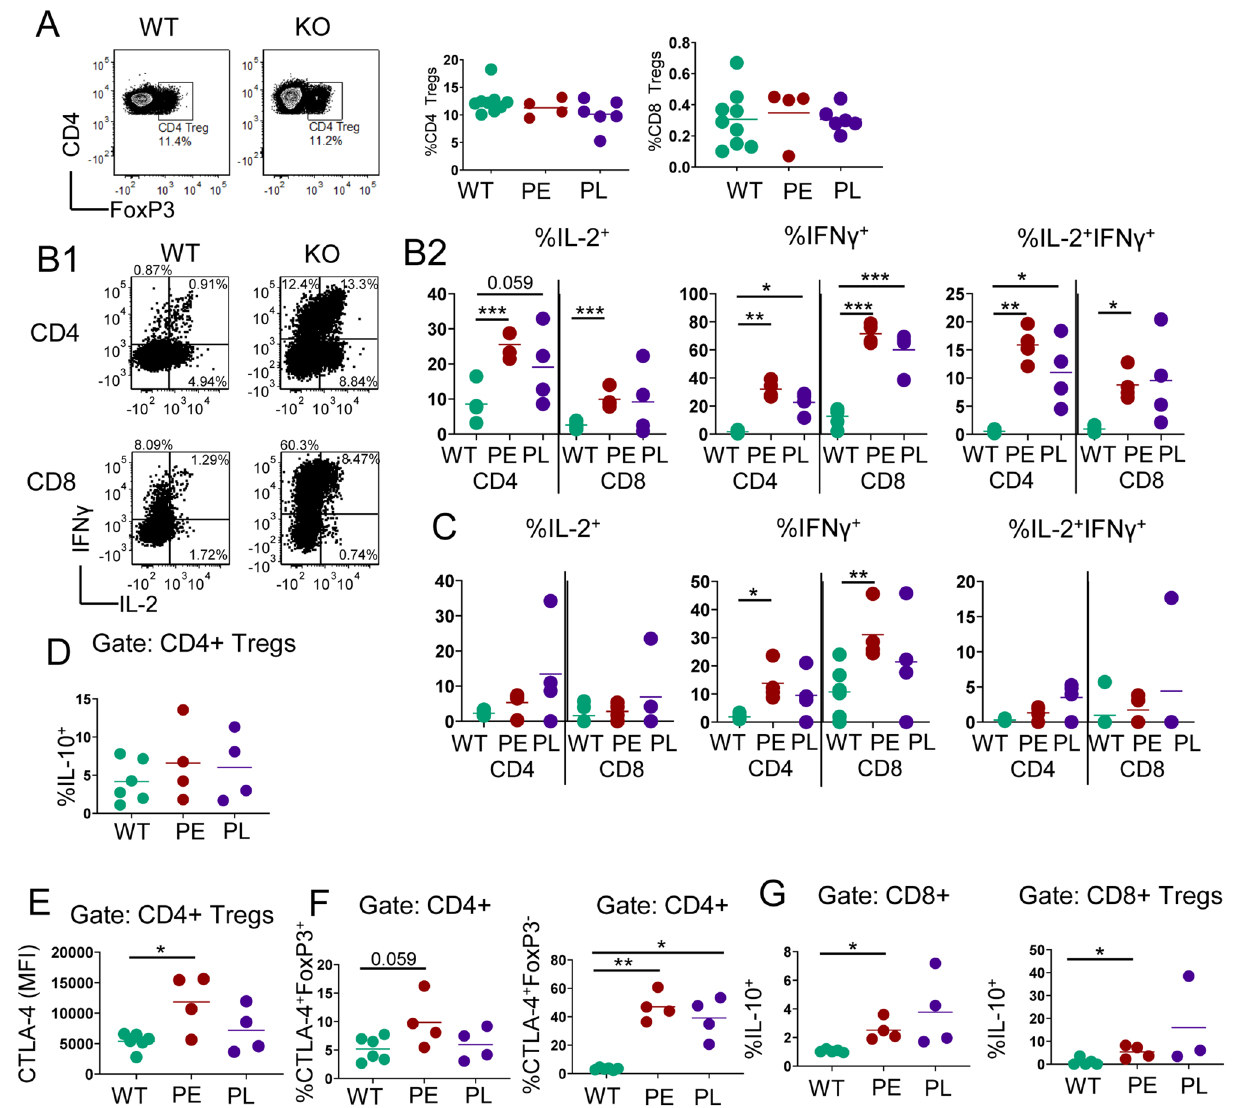
Figure 4. IL-2Rα-KO Tregs acquire effector functionality. ( A ) Representative flow plots, and frequency of CD4 and CD8 Tregs in the spleen in 19-day-old WT and IL-2Rα-KO mice. n = 4–11 mice per experimental group. Representative flow plots and frequency of T cells producing IL-2 and IFNγ in 19-day-old WT and IL-2Rα-KO LN T cells ( B1 , B2 ) or Tregs ( C ) post 5-h PMA and ionomycin stimulation. n = 4–6 mice per experimental group. ( D ) CTLA-4 expression on CD4 Treg cells at day 19 by mean fluorescent intensity (MFI). ( E ) Frequency of IL-10+ 19-day-old WT and IL-2Rα-KO CD4 Treg cells post 5-h PMA and ionomycin stimulation. ( F ) Frequency of CTLA-4+FoxP3+CD4 T cells or CTLA-4+FoxP3− CD4 T cells are shown for 19-day-old WT and IL-2Rα-KO mice. ( G ) Frequency of IL-10+ 19-day-old WT and IL-2Rα-KO CD8 T and CD8 Treg cells post 5-h PMA and ionomycin stimulation. n = 4–6 mice per experimental group over 4 independent experiments. Statistics: unpaired Student’s t test; *p < 0.05, **p < 0.01, ***p < 0.001. Non-significant comparisons are not